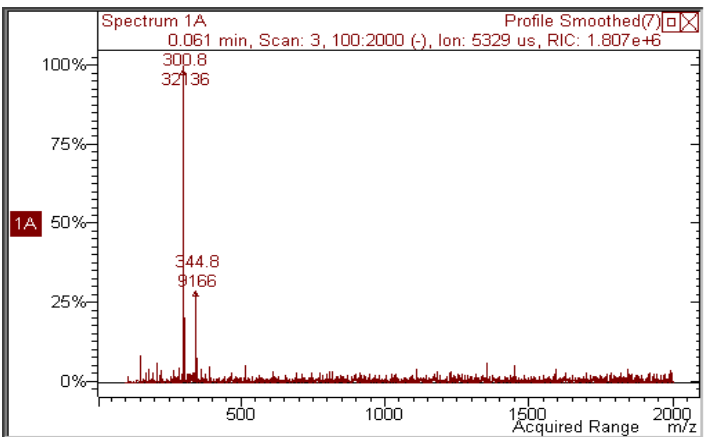
Figure 3. Negative-ion mass spectrum of a 2 × 10 − 5 M solution of quercetin in ethanol irradiated with 50 J/cm 2